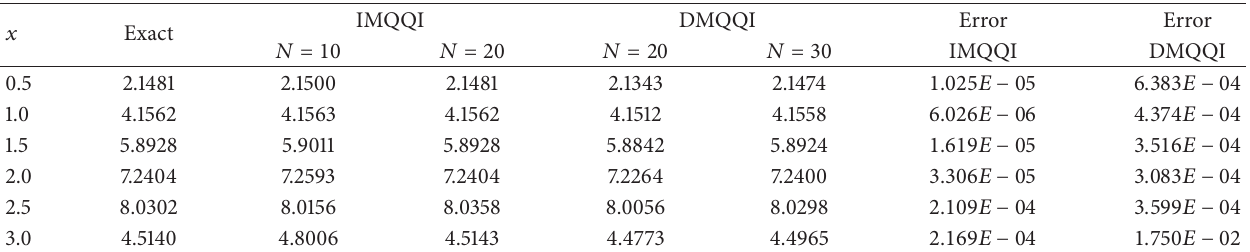
Table 8: Comparison of numerical results with the exact solutions for 𝜐 = 1 with 𝑞 = 20 and Δ𝑡 = 0.001 at 𝑡 = 3 of Experiment 5. 𝑥